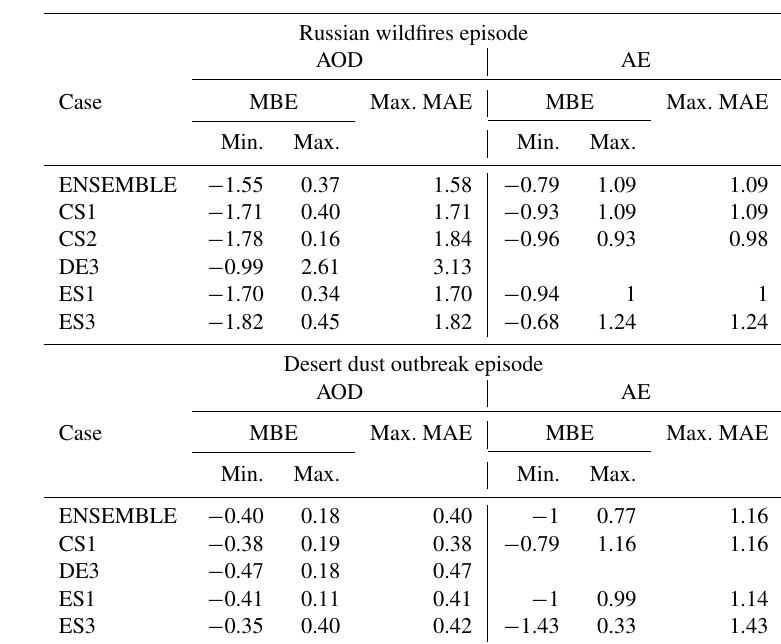
Table 3. Spatial results from evaluating the NRF simulations.